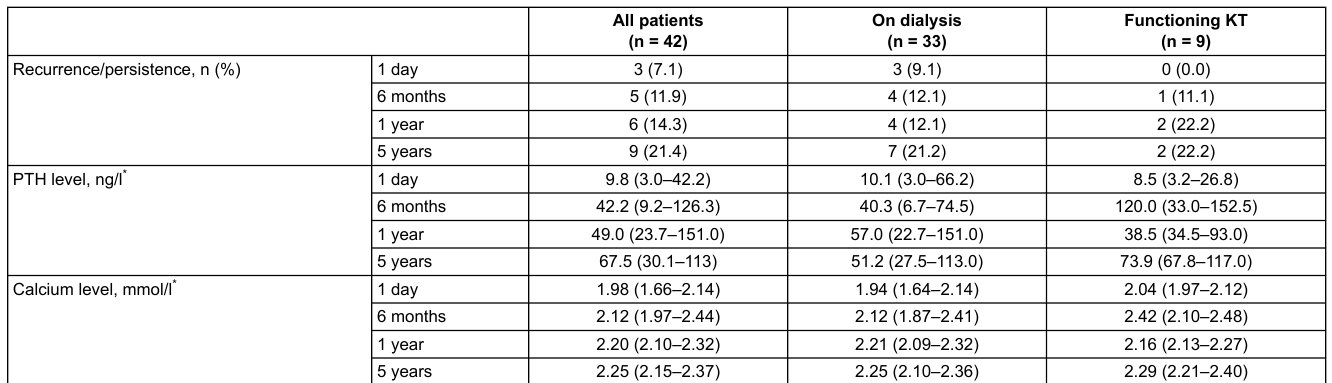
Table 2: Postoperative follow-up.